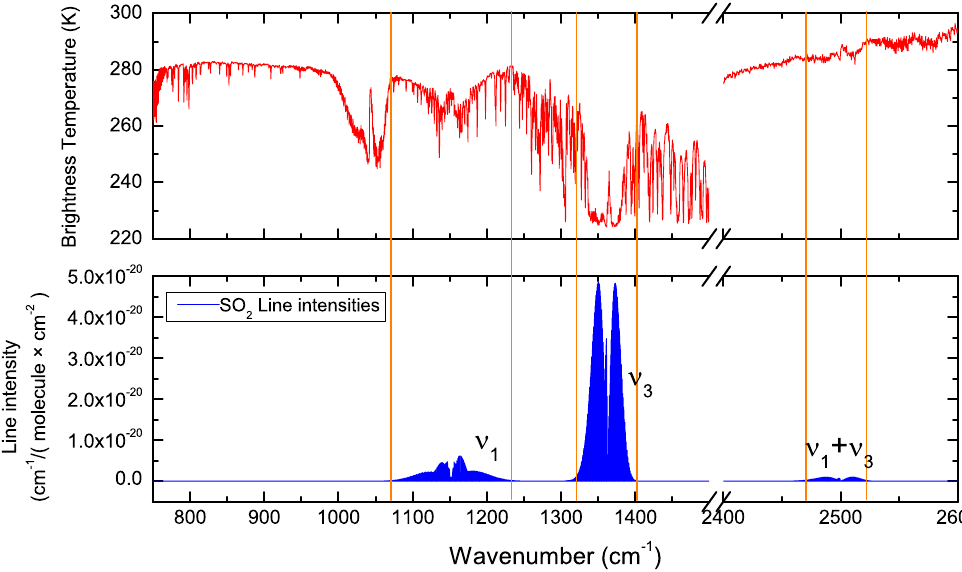
Fig. 1. Top panel: example IASI spectrum measured over the plume of the August 2008 eruption of Kasatochi. Bottom panel: line positions and intensities of SO 2 from HITRAN (see Rothman et al., 2009, and references therein). Band centers and inte- grated band intensities of SO 2 are (see Flaud et al., 2009, and references therein): the ν 1 symmetric stretch ( ∼ 1152cm − 1 =8.7µm at 0.35 × 10 − 17 cm − 1 /(molecule cm − 2 )), the ν 3 asymmetric stretch ( ∼ 1362cm − 1 =7.3µm at 2.72 × 10 − 17 cm − 1 /(molecule cm − 2 )) and the